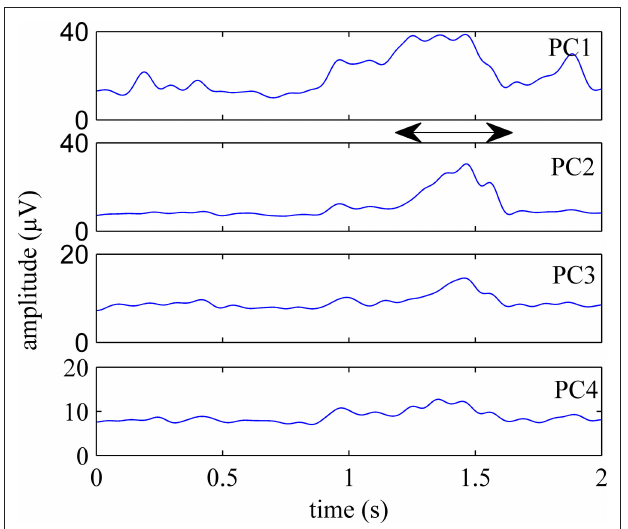
Figure 6 | rectified-averaged version of the PCs shown in Figure 5. Neural components were observed during behavior in all channels. Although they are similar, each component has a distinct appearance.